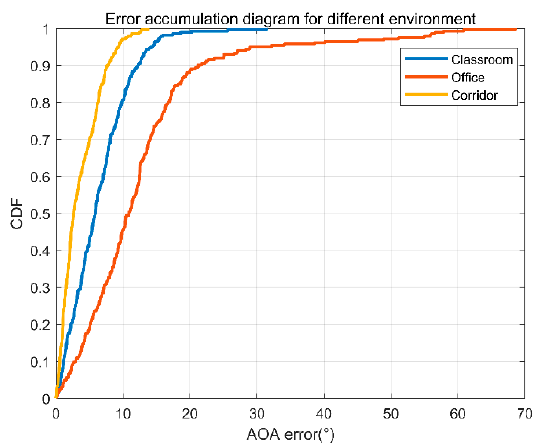
Figure 14. AOA error accumulation diagram of three different environments.